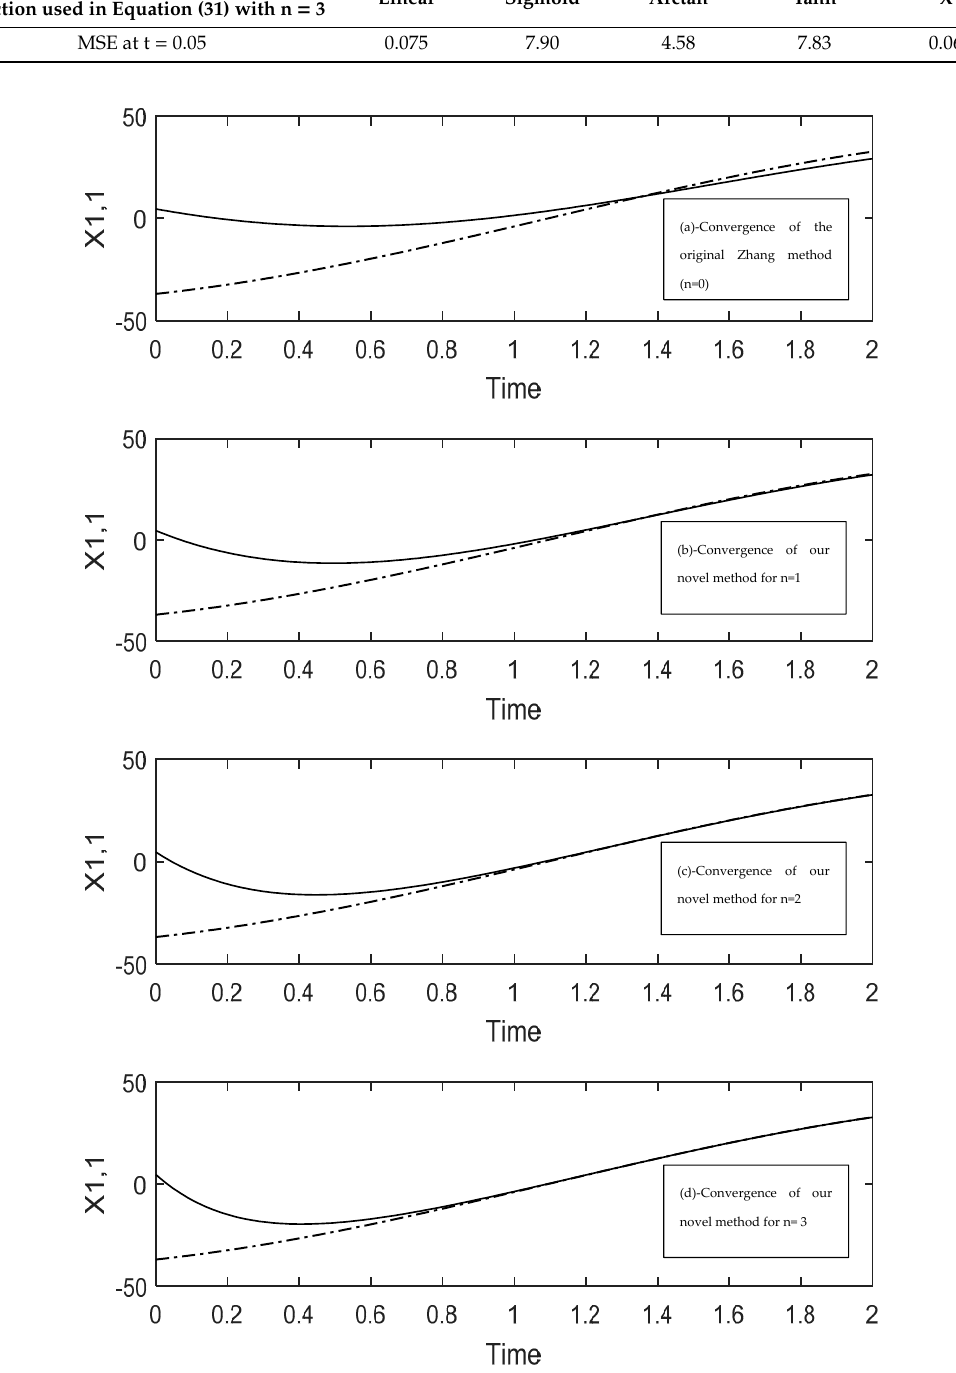
Figure 5. Showing the difference in convergence speed between the original Zhang method and our new developed method (see Equation (24)). The solid lines are the one obtained from the model solving and the dashed lines are the target values. ( a ) convergence of the original Zhang model; ( b ) until ( d ): convergence profiles of our novel method for different values of n. All graphs (a) until (d) are plotted for the first element of the time-varying matrix M (i.e., first row, first column).